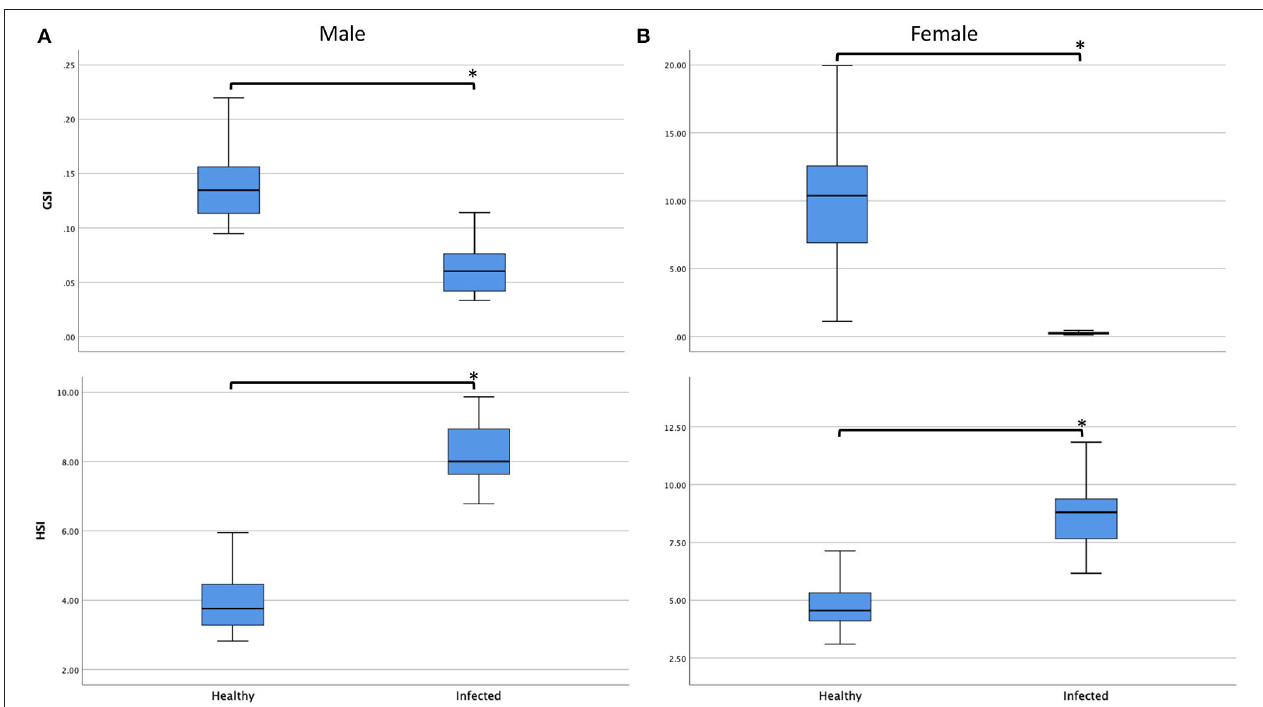
FIGURE 3 | Boxplots showing the gonadosomatic index (GSI, %) and hepatosomatic index (HSI, %) of healthy and infected (A) males and (B) females. All comparisons showed significant differences ( P < 0.05, marked with asterisk *). Infection by Sacculina beauforti resulted in significant reduct0069on in GSI but increment in HIS of Scylla olivacea